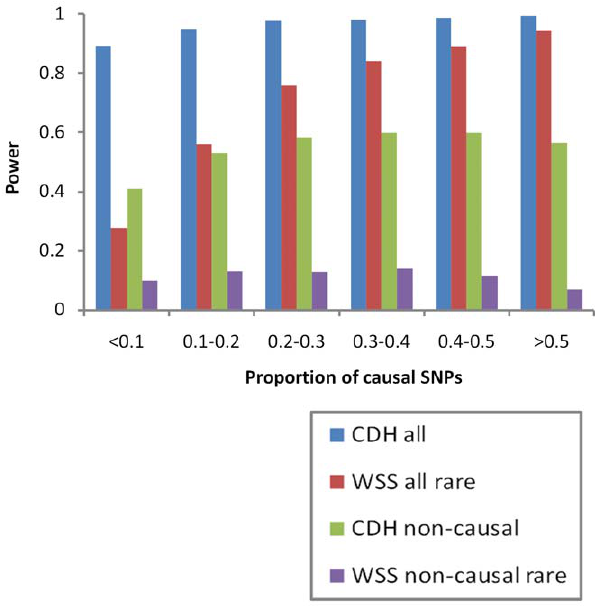
Figure 4. The power of CDH and WSS. The power of CDH and weighted sum statistic (WSS) [29] was plotted against the portion of causal variants in the sampled region. A region spanning 200 kb was randomly sampled 10,000 times over the Illumina 550 K chip without replacement. For each sampling, a binary trait was simulated by considering a portion of the rare variants in the region to be causal under the recessive-set model described in [29]. Other parameters were fixed ( a =0.05, n=10,000, and GRR =10 for carriers of any homozygote or CH genotype of the causal variants). Four sets of P values were derived when (1) all SNPs in the region were analyzed by CDH (blue), (2) all SNPs with MAF , 0.05 were analyzed by WSS (red), (3) all non-causal SNPs were analyzed by CDH (green), and (4) all non-causal variants with MAF , 0.05 were analyzed by WSS (purple). The power was defined as the portion of P values smaller than or equal to 5 6 10 -8